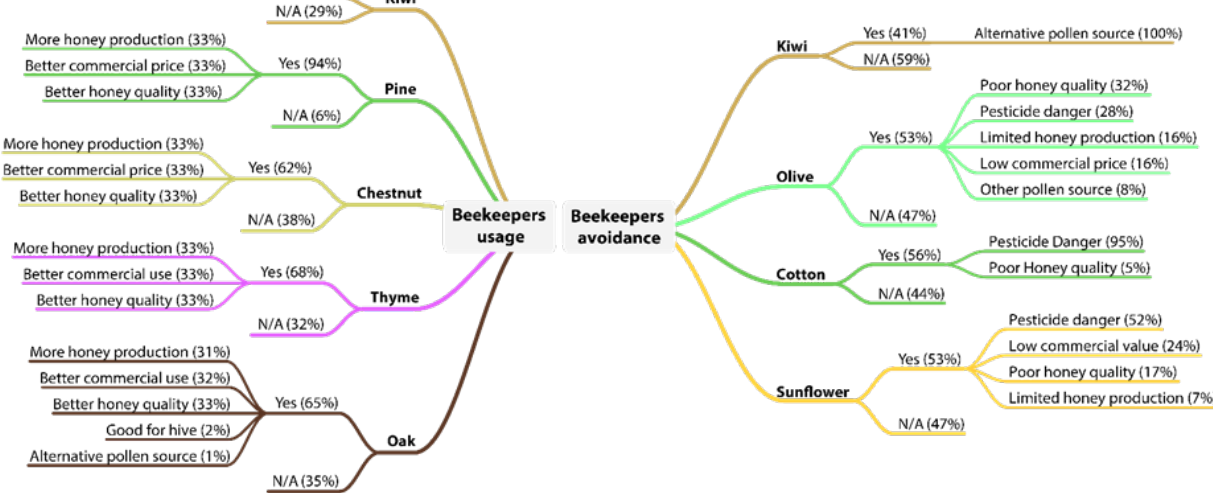
Figure 4. Beekeepers’ usage and avoidance of different trees and crops .